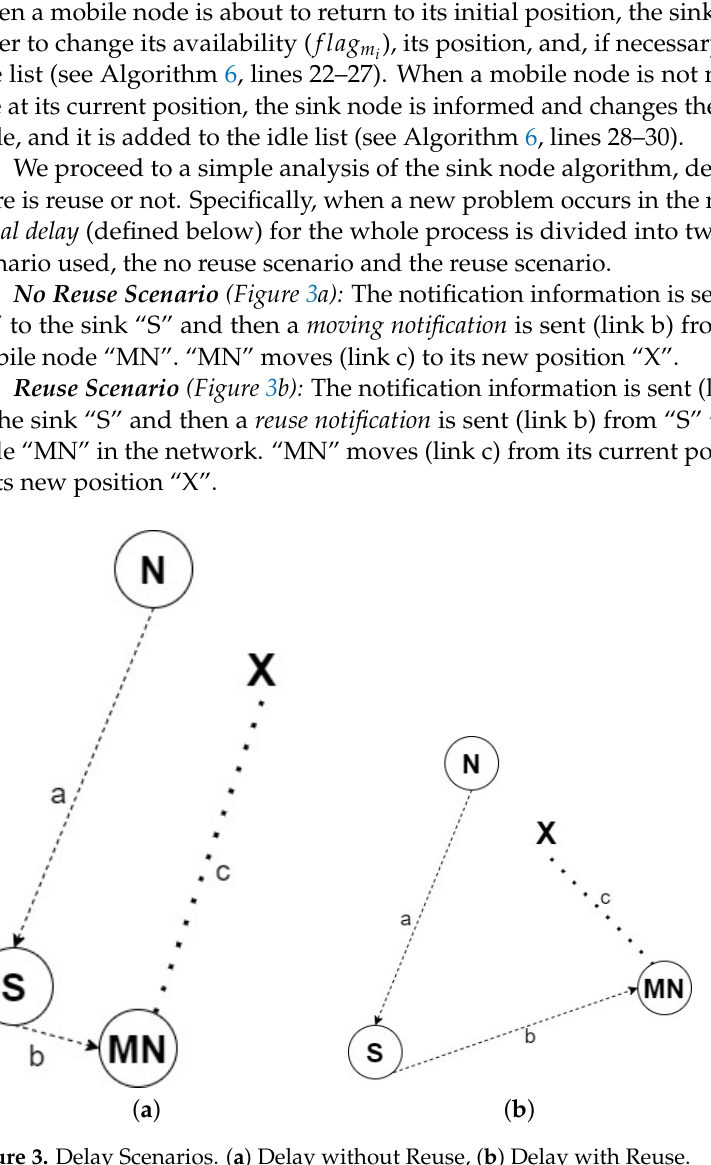
Figure 3. Delay Scenarios. ( a ) Delay without Reuse, ( b ) Delay with